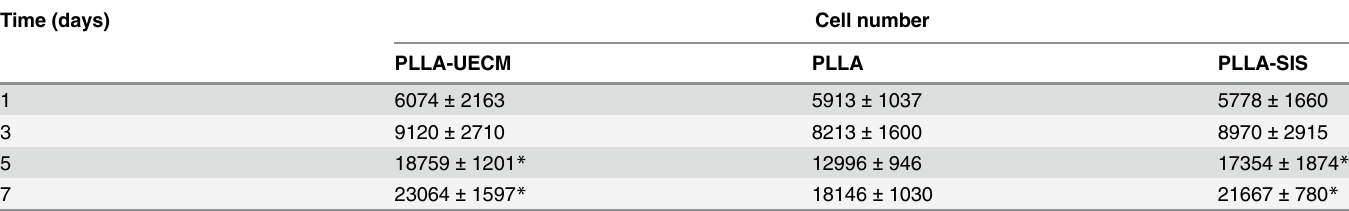
Table 2. Proliferation analysis by the MTT assay. All values are expressed as means ± standard deviation and were analyzed with a one-way ANOVA. Time